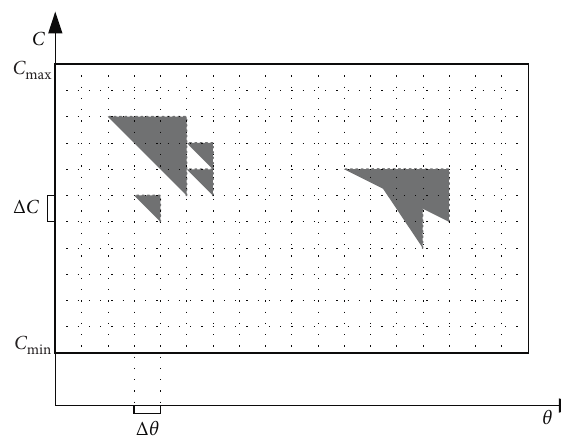
Figure 2: Hough transform ballot